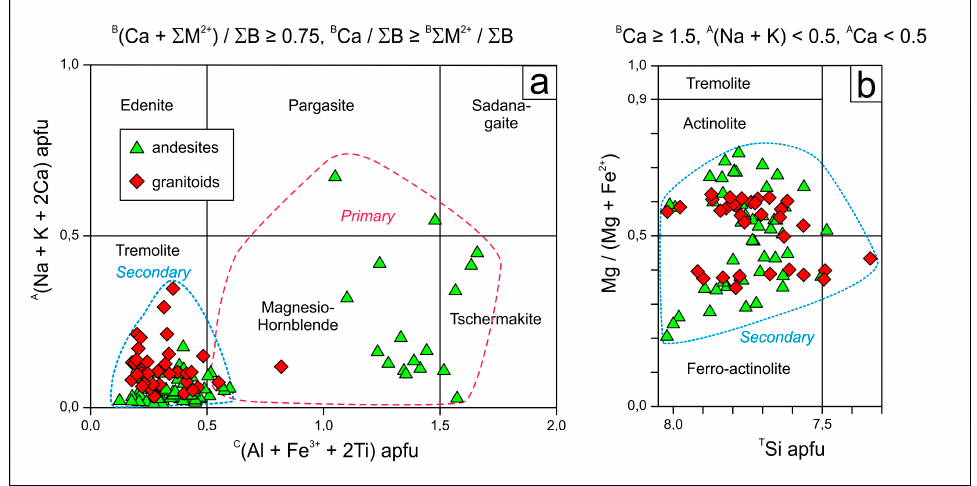
Figure 8. Proxy diagrams for amphibole classification [88–90], ( a ) calcium amphiboles and their compositional boundaries, and ( b ) classification diagram for amphiboles belonging to